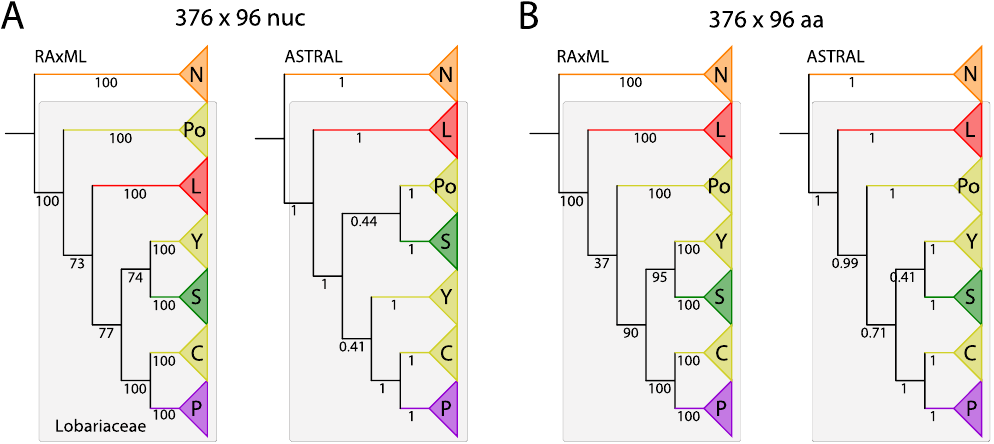
Figure 1. Tree topologies estimated with nucleotide ( A ) and amino acid ( B ) data and different tree reconstruction methods (RAxML concatenated vs. ASTRAL species tree). Nodal support, either as bootstrap (RAxML) or local posterior probability (ASTRAL) is depicted under the branches. Abbreviations are as follows: N = Nephroma (outgroup); L = Lobaria s . lat . clade (also including Anomolobaria , Dendriscosticta , Lobariella , Lobarina , Ricasolia , and Yoshimuriella ); Po = Podostictina ; S = Sticta ; Y = Yarrumia ; C = Crocodia ; P = Pseudocyphellaria .